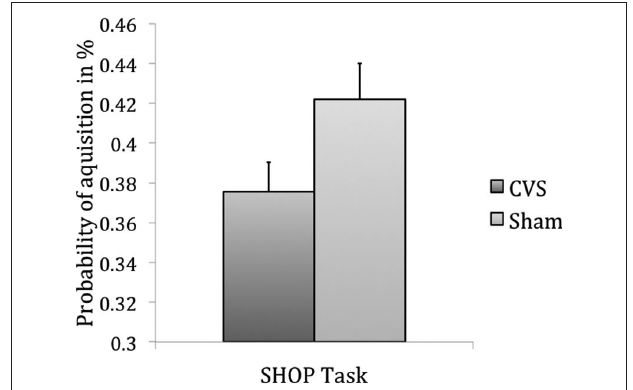
FIGURE 2 | Results of Experiment 1, item-based analysis: CVS decreased probability of buying a product ( p =